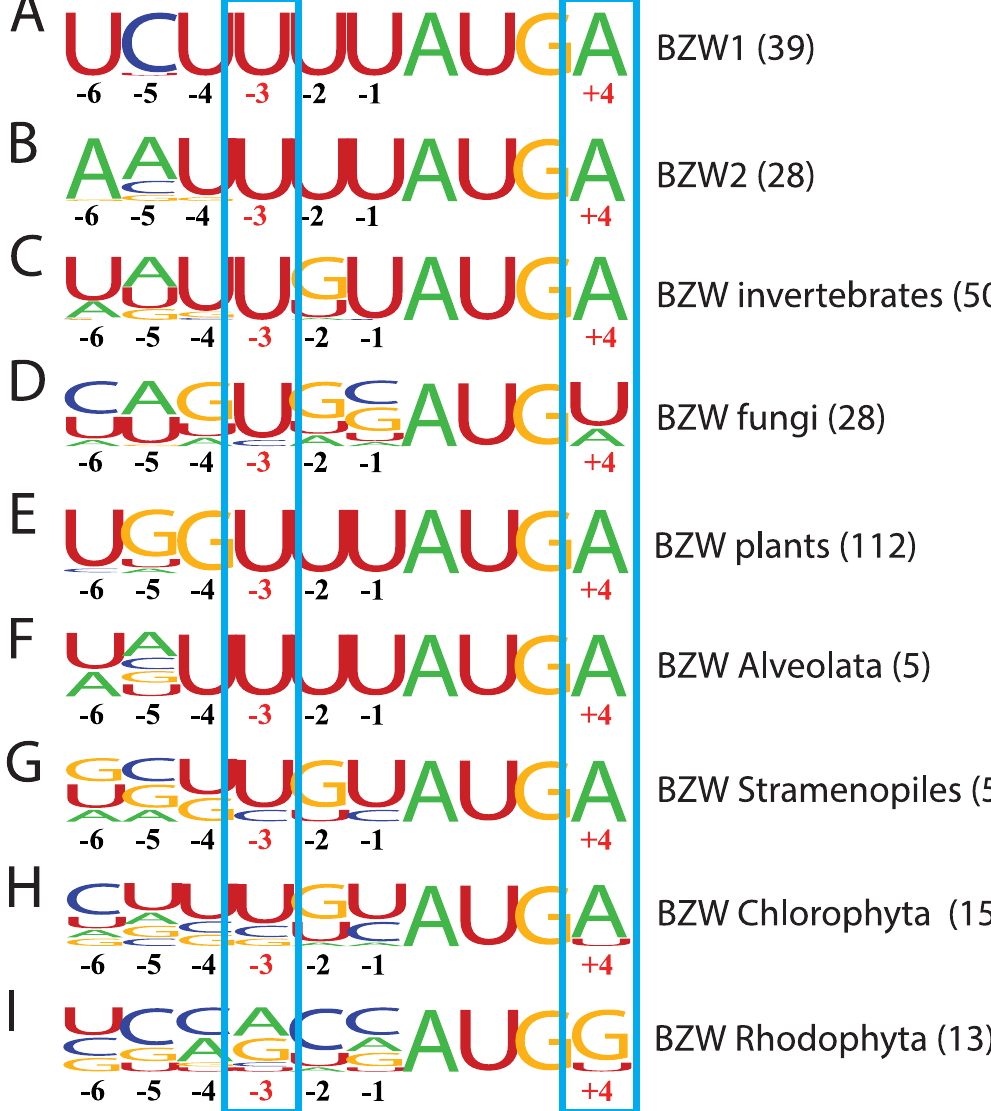
Fig 1. The AUG start codon of BZW homologs in eukaryotes is in conserved poor initiation context. The sequences surrounding the start codon of BZW homologs, from position −6 to +4, were aligned for the evolutionary branch indicated and the alignment represented as a frequency logo [34], with the height of each letter proportional to the frequency with which the corresponding nucleotide occurs at a given position. Alignment of: (A) BZW1 orthologs in vertebrates; (B) BZW2 orthologs in vertebrates; (C) BZW homologs in invertebrates; (D) BZW homologs in fungi; (E) BZW homologs in land plants; (F) BZW homologs in Alveolata; (G) BZW homologs in brown algae; (H) BZW homologs in green algae; and (I) BZW homologs in red algae. The critical positions −3 and +4 are indicated with red numbers and also boxed. Numbers in parentheses indicate the number of sequences in each alignment.